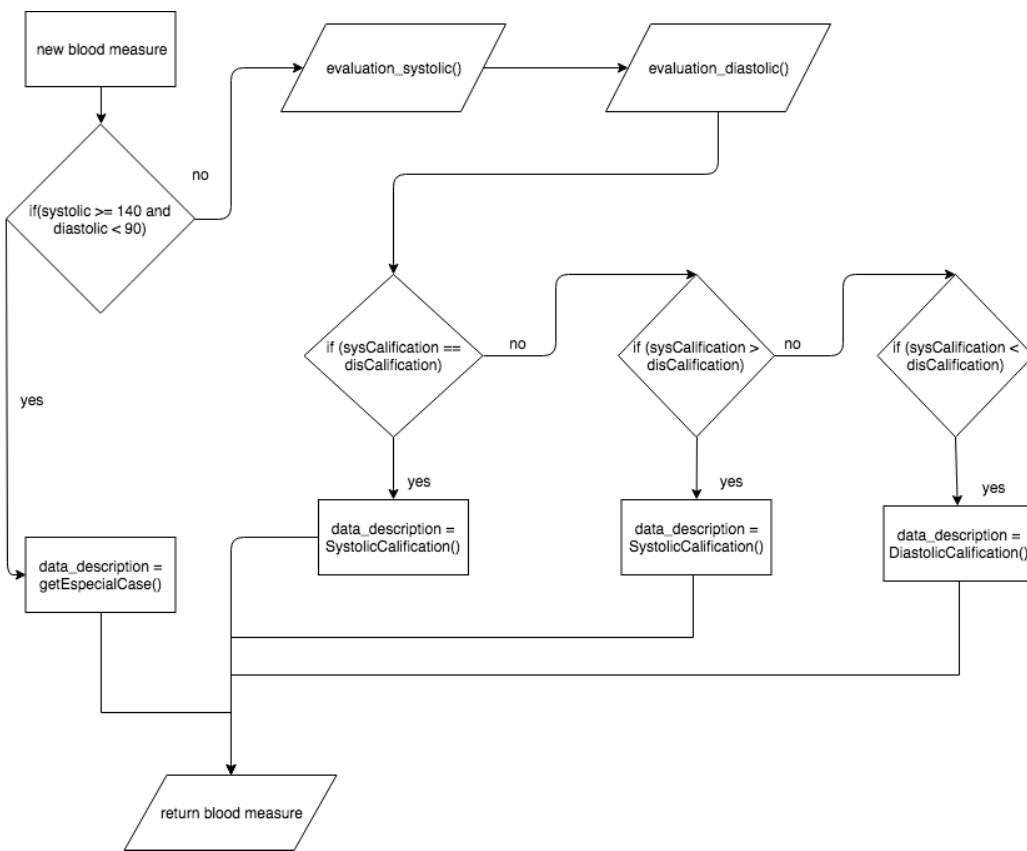
Figure 14. Process of qualifying blood pressure classification.